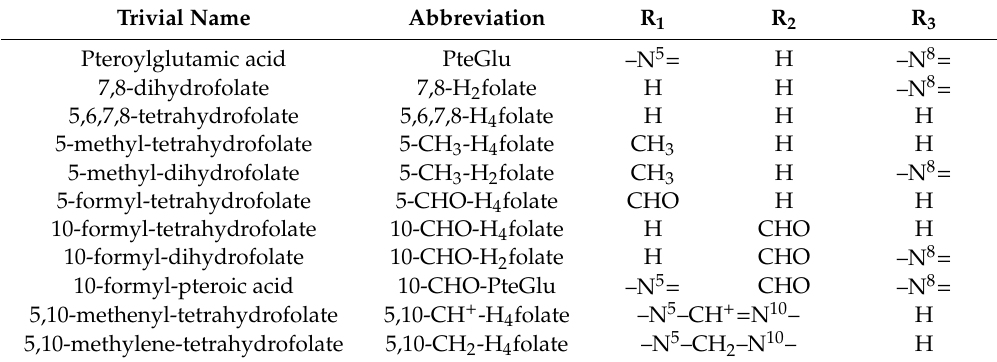
Figure 1. Molecular structure of main folate vitamers known so far. Table 1. Substitution of main folate vitamers known so far.